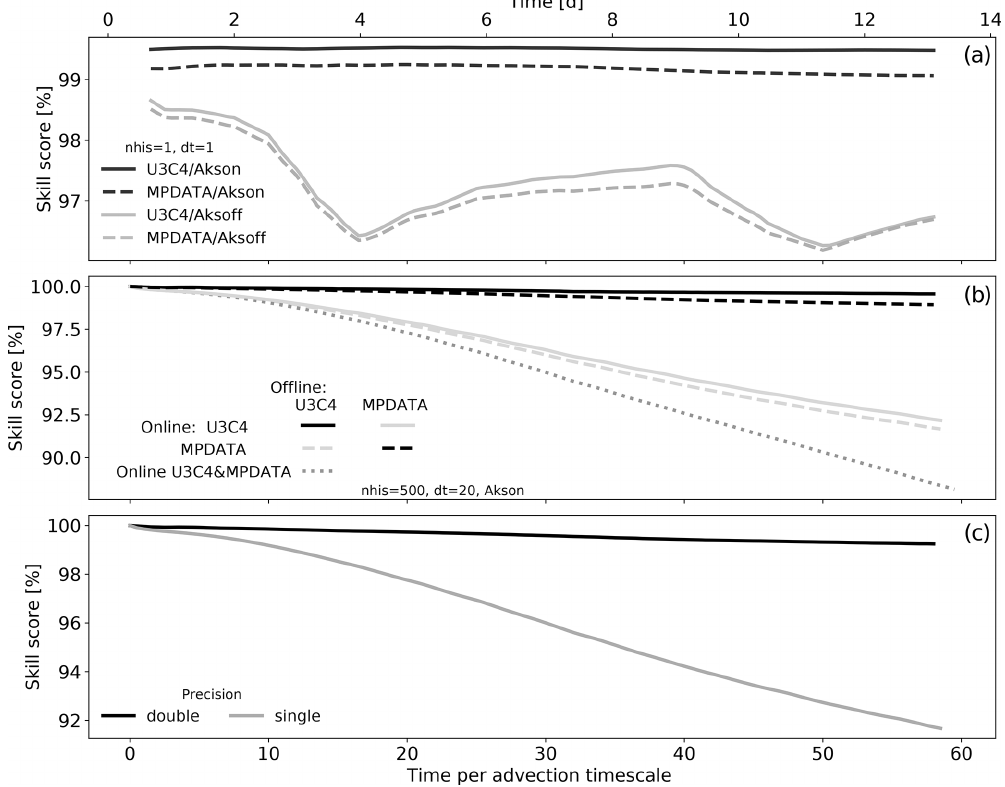
Figure 5. (a) Skill score compared with persistence is shown for combinations of tracer advection schemes and whether online Aks is forced. The simulations shown are the same as in Fig. 4a. (b) Comparison of skill score simulations forced by several combinations of tracer advection schemes. The combinations are as follows: online simulation using U3C4 with offline simulation using U3C4 (black solid line), online simulation using U3C4 with offline simulation using MPDATA (gray solid), online MPDATA with offline U3C4 (gray dashed) and with offline MPDATA (black dashed), and a comparison between results from online U3C4 and online MPDATA (gray dotted). (c) Skill score for double-precision compared with single-precision online